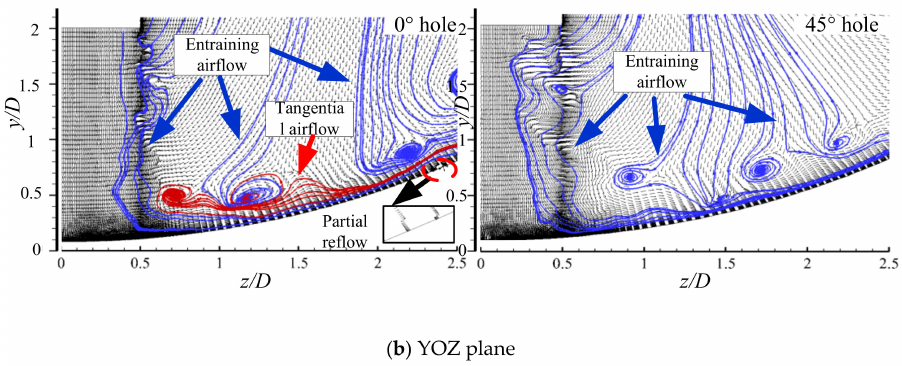
Figure 8. Streamlines and velocity vectors in the XOY and YOZ planes.